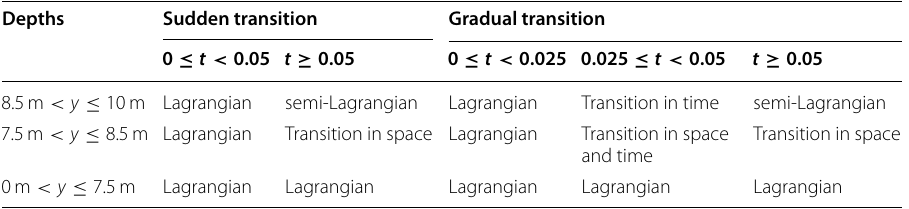
Table 2 Sudden and gradual temporal transitions from L‑RK to SL‑RK approximations in time and space; the y ‑coordinate is measured from the bottom of the soil layer Depths Sudden transition Gradual transition 0 ≤ t < 0.05 t ≥